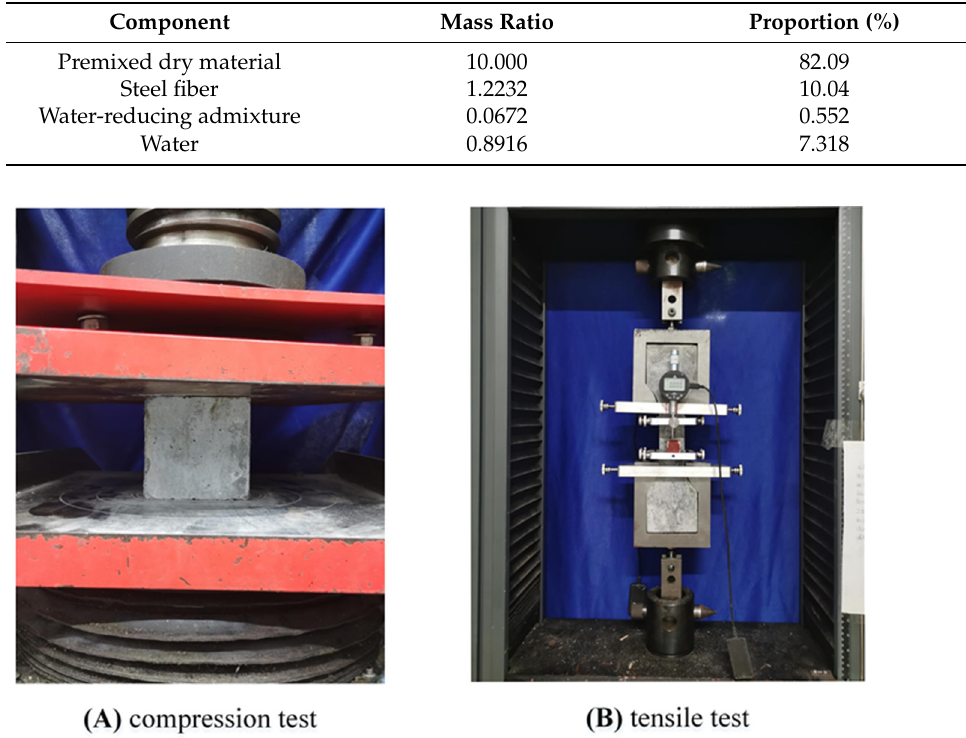
Table 2. Mix the proportion of UHPC.